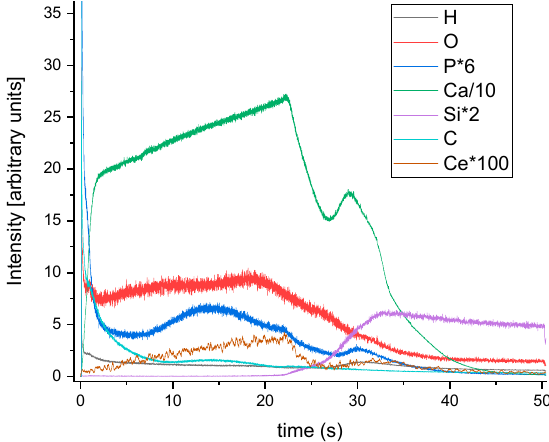
Figure 4. Elemental depth profiles of the 5Ce-HAp thin film deposited by radio frequency (RF) magnetron sputtering discharge on the Si substrate.